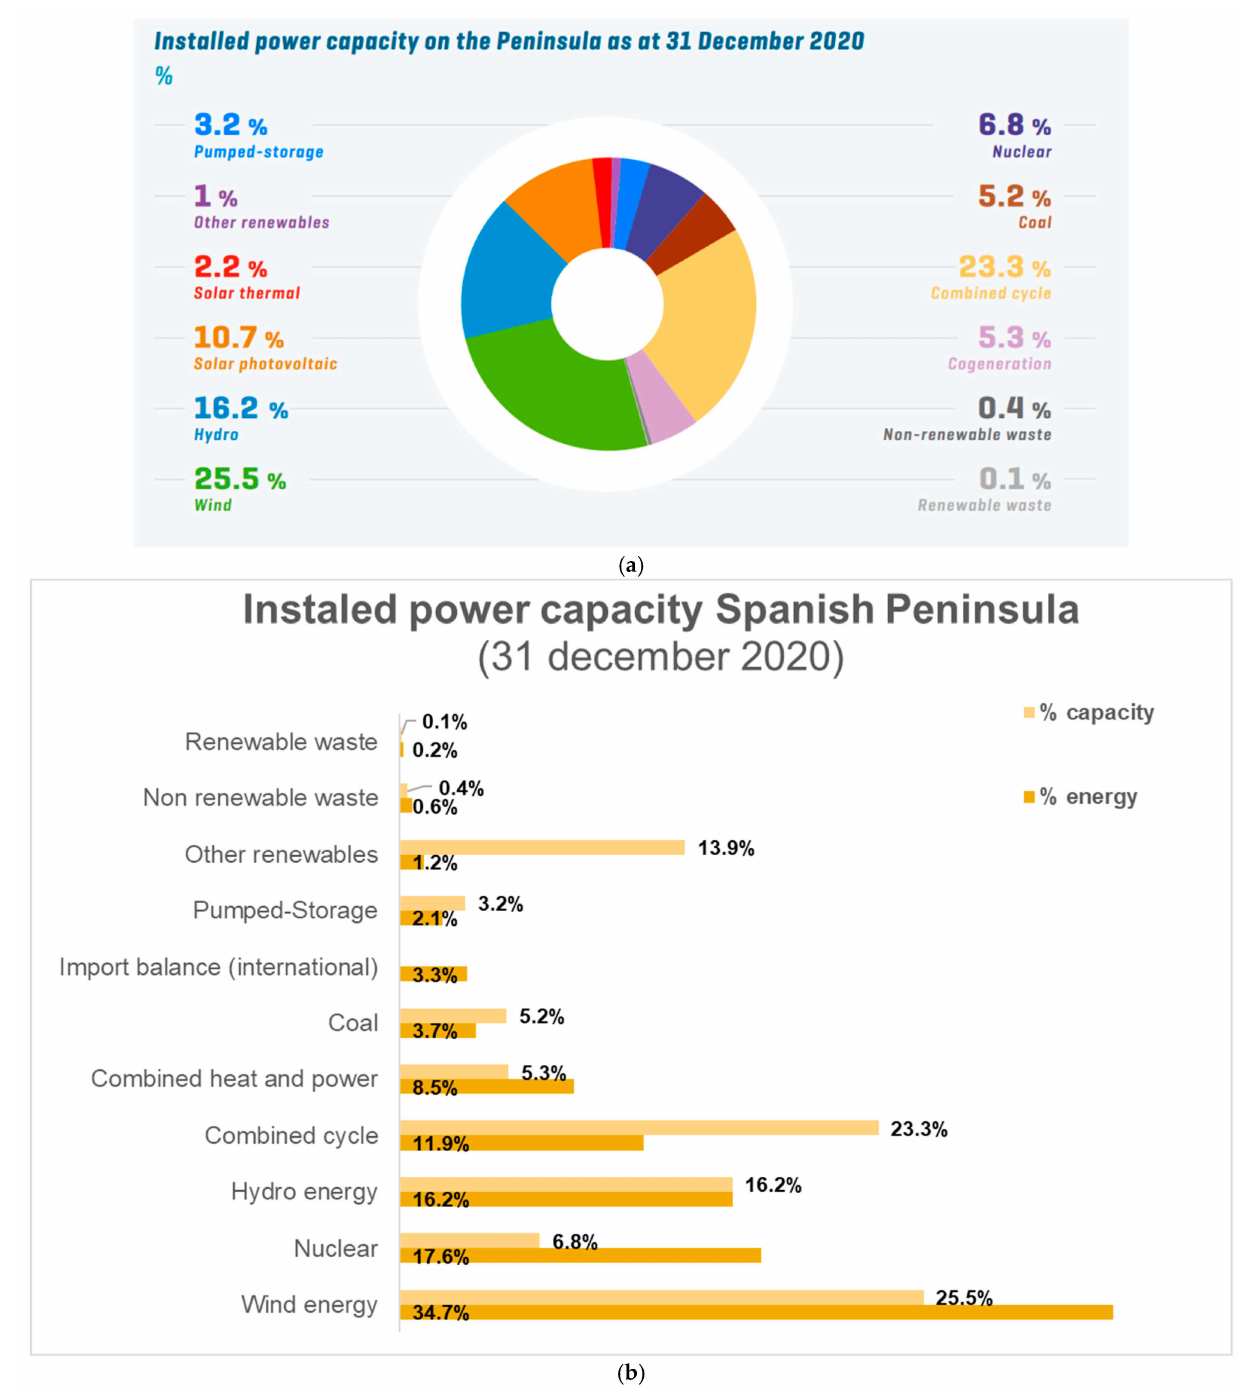
Figure 2. ( a ) Installed power capacity in the generation system on the Spanish Peninsula for each source; ( b ) installed power capacity and generation share on the Spanish Peninsula for each